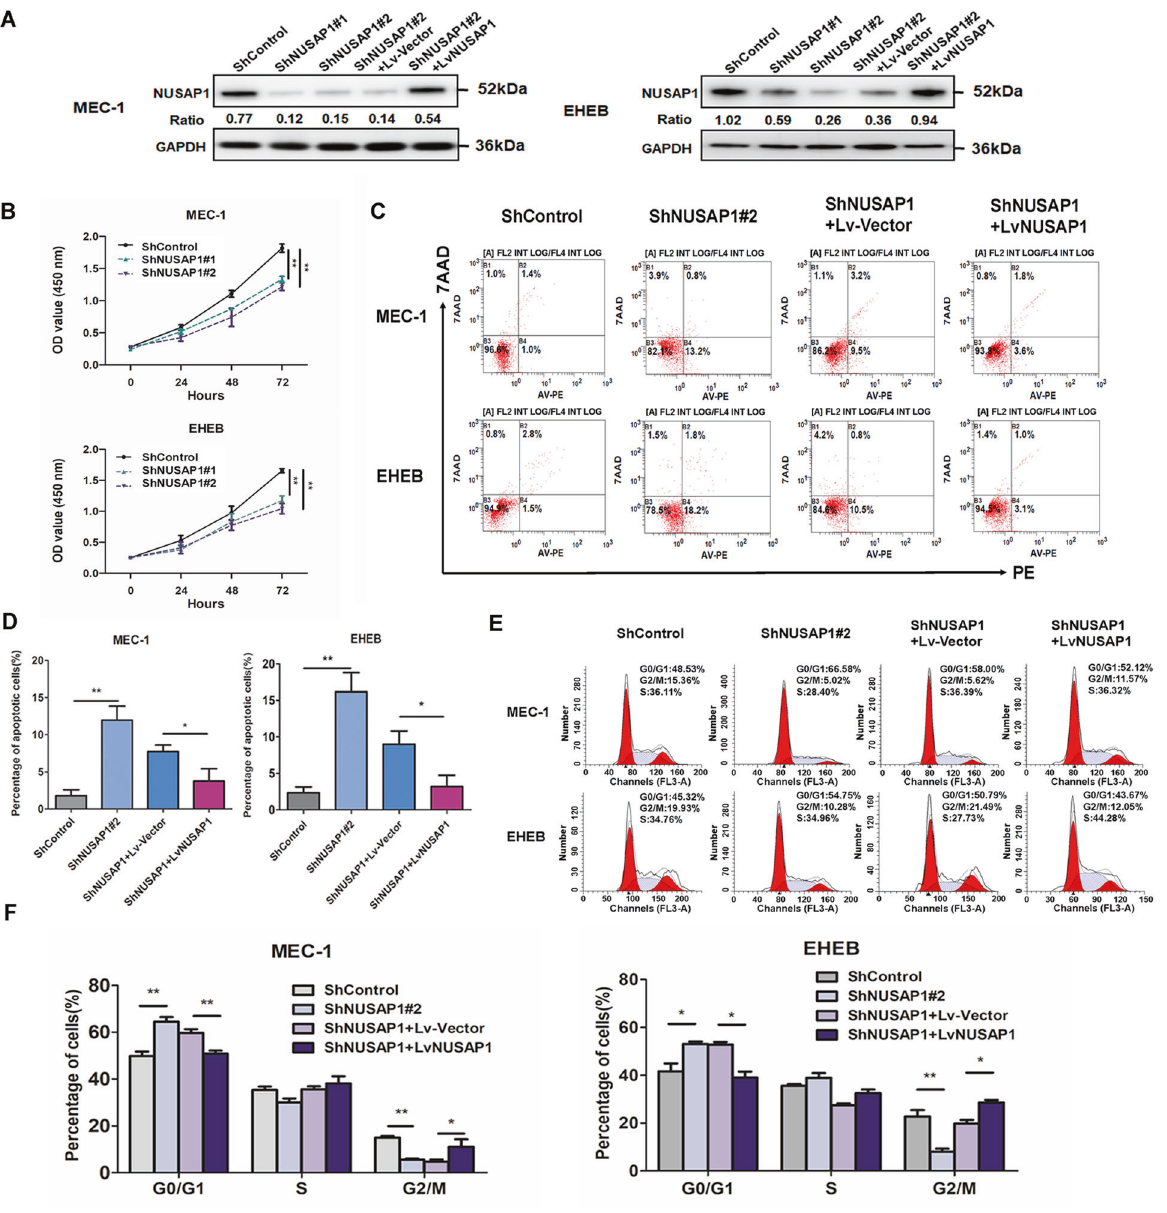
Fig. 3 Cell proliferation decline, apoptosis rising and cell cycle arrest accompanied with NUSAP1 silencing. A Western blotting veri fi cation of CLL cells with NUSAP1 knockdown and recovered. B OD values of NUSAP1 knockdown CLL cells by CCK-8. C Test of apoptosis by fl ow cytometry in cells with NUSAP1 decrement and recovered. D The relative apoptotic rates in CLL cells with NUSAP1 knockdown and recovered. E Detection of cell cycle in cells with NUSAP1 decrement and recovered by fl ow cytometry assay. F The relative rates of cells in different cell cycle phases. All data are presented as the mean ± SD, n = 3. * p < 0.05; ** p <